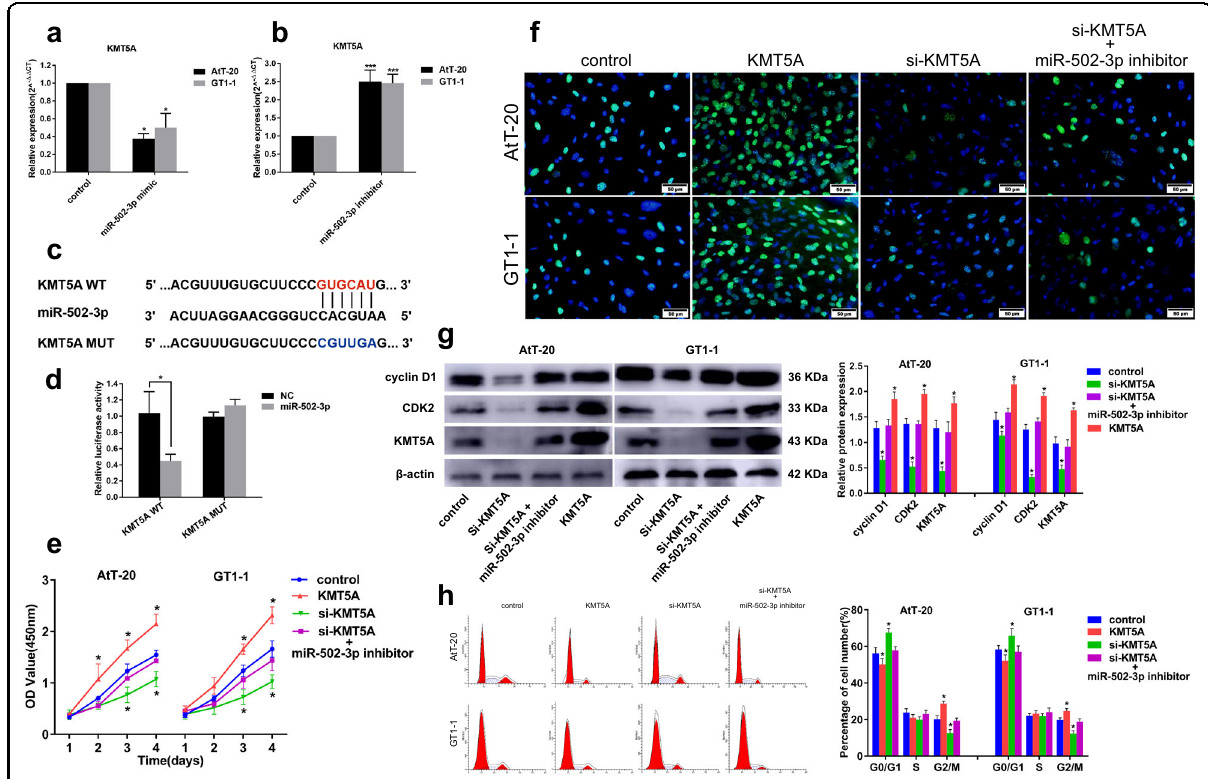
Fig. 5 The role of KMT5A in promoting proliferation of PA cells was regulated by miR-502-3p. qRT-PCR detection of KMT5A mRNA expression in PA cells AtT-20 and GT1-1 after transfection of miR-502-3p mimic ( a ) and inhibitor ( b ). c Prediction of binding sites for KMT5A and miR-502-3p, wide type and mutant type of KMT5A were designed for luciferase reporter assay. d Dual luciferase reporter gene assay was used to detect the binding ability between KMT5A and miR-502-3p. e CCK-8 detection of PA cells viability after overexpression of KMT5A, knockdown of KMT5A, or knockdown of KMT5A while inhibition of miR-502-3p. f Cell proliferation was determined by EdU staining. g Western blot analysis of cyclin D1, CDK2, and KMT5A expression. h Cell cycle was analyzed by fl ow cytometry. * P < 0.05, ** P < 0.01, *** P < 0.001, data represent the mean ±